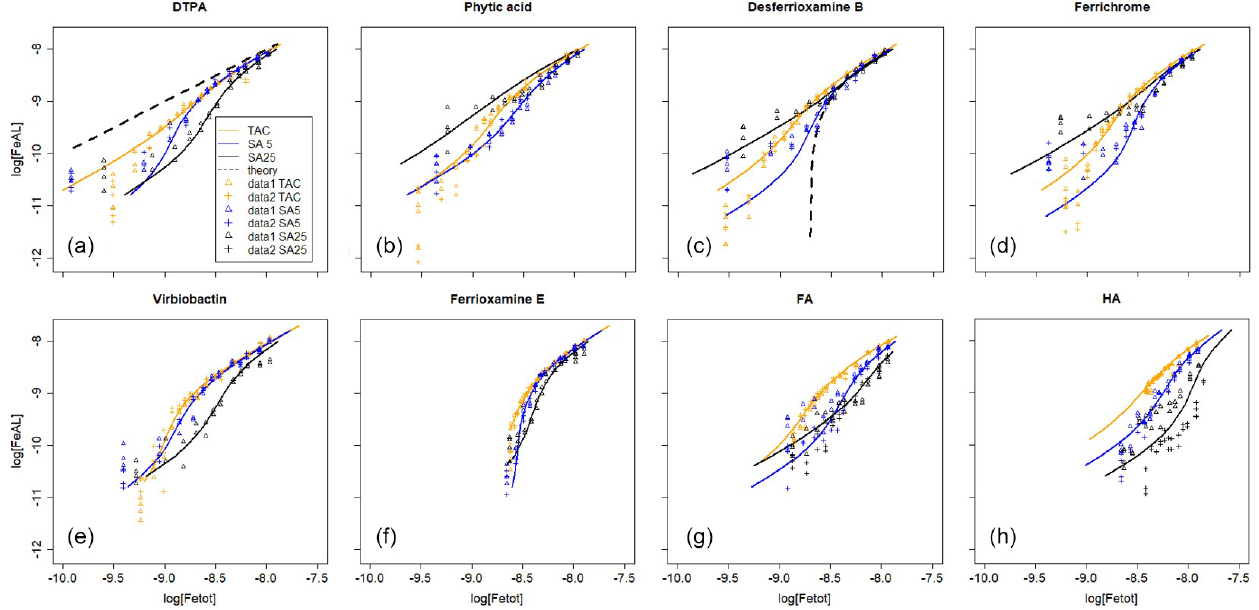
Figure 2. Iron titrations of UV-irradiated seawater containing model ligands in competition with TAC, SA5 and SA25 as added ligand (FeAL) versus total dissolved Fe. The same data as in Fig. 1 are presented but with a log-log transformation. The lines represent back calculated titration curves with the data from Table 2, and the markers are the actual data points. The dashed black lines in (a) and (c) are back-calculated titration curves using theoretical K cond calculated from the thermodynamic constants and 2nM as model ligand concentration. (a) DTPA, (b) phytic acid, (c) desferrioxamine B , (d) ferrichrome, (e) ferrioxamine E (saturated with Fe), (f) vibriobactin, (g) fulvic acid FA and (h) humic acid HA. Data for TAC and SA5 are from duplicate experiments, and data for SA25 are from single experiments, except for FA and HA where for SA25 duplicate experiments were also done. Note the different HA concentrations, 0.1 and